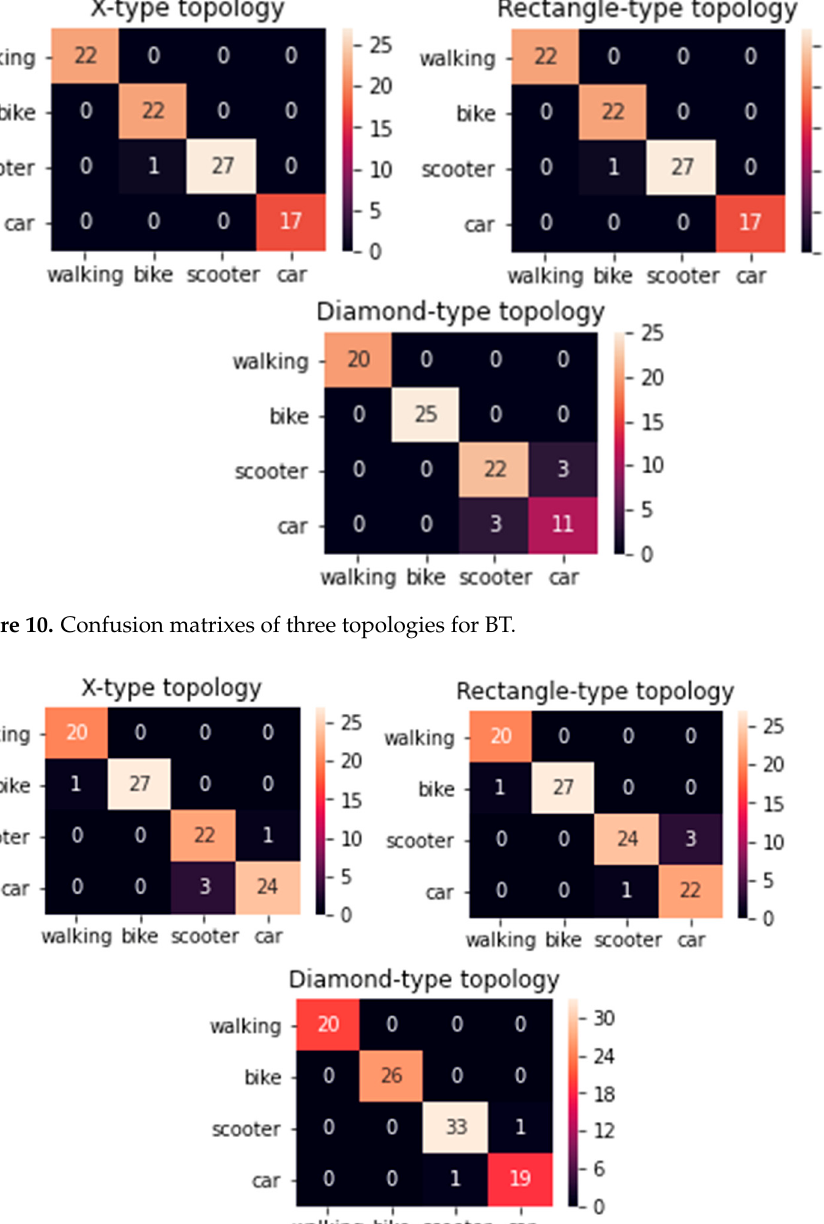
Figure 12. TMP accuracy. 5.2. Lane Identification Problem (LIP) The experiment collected wireless signals in different lanes and routes. The field of the experiment was on Chengnan Rd., Annan Dist., Tainan, Taiwan (as shown in Figure 13). It is a semi-enclosed field with two lanes on each direction. In this experiment, ten mobile devices were put in the car with Wi-Fi and BT being on. A car with 10 mobile devices passed by the ITB several times at a speed of 30 km/h, which indicates the average travel speed of a road section in an urban scenario. Two scenarios were performed in this experiment.